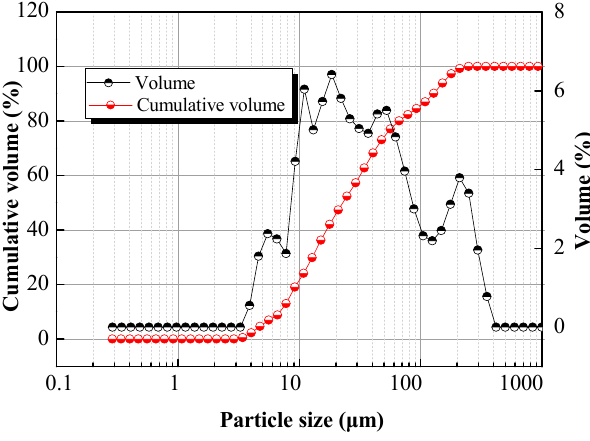
Figure 5. Particle size distribution of FA.